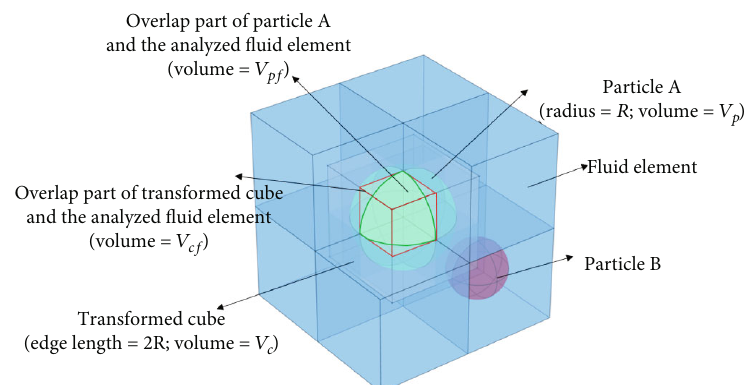
Figure 2: Diagram of porosity by cube method.